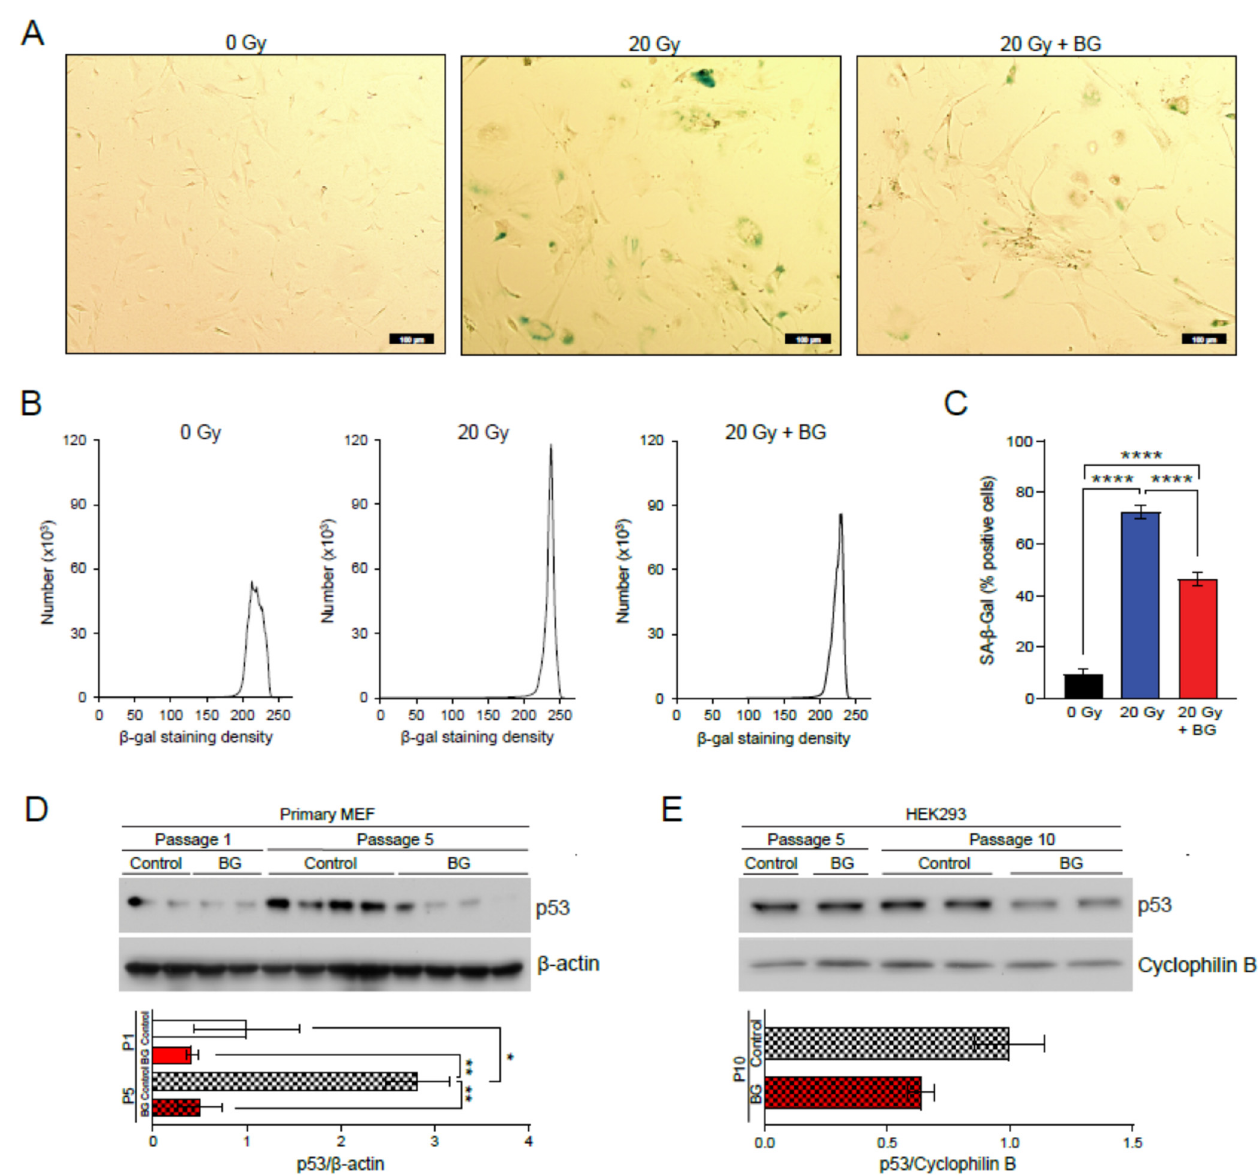
Figure 1. Representative morphologies of senescence-associated β -galactosidase ( β -gal) stained (bluish-green color) primary mouse embryonic fibroblasts (MEFs) with 0 Gy, 20 Gy, 20 Gy+BG (5 μ g/mL) (scale bar = 100 μ m) ( A ), SA- β -gal quantification plots based on staining density ( B ), and SA- β -gal quantification plots based on percentage of positive cells ( C ), p53 protein expression levels in primary MEF at passage 1 (n = 2 per group) and passage 5 (n = 4 per group) with control and BG treatment (5 ug/mL) ( D ), p53 protein expression levels in human embryonic kidney (HEK) 293 cells at passage 5 and 10 (n = 1–2 per group) with control and BG treatment ( E ) * p ≤ 0.05, ** p ≤ 0.01 and **** p ≤ 0.0001.